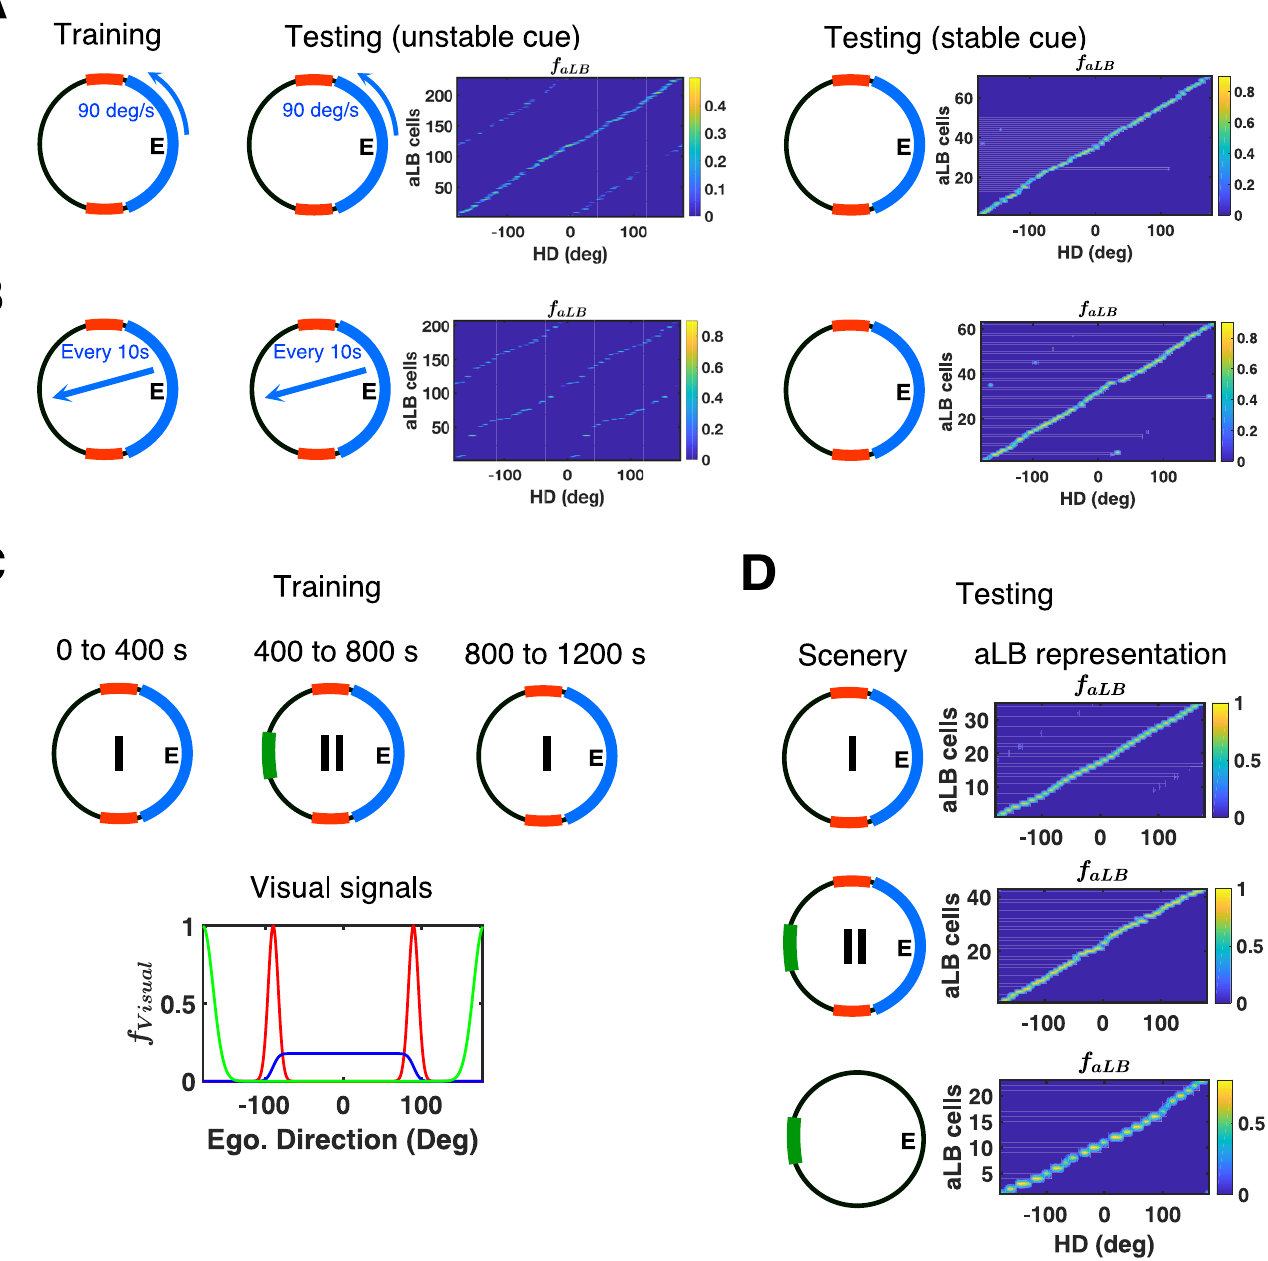
Fig 3. aLB cells exhibit robustness against unstable or ephemeral cues, and can incorporate novel cues. (A) Single environment (same as Fig 1B) with the ‘blue’ cue moving along the cylinder with 90 deg/s anticlockwise during training (left). Global representation of aLB cells tested on the unstable scenery with ‘blue’ cue moving by 90 deg/s anticlockwise (middle, ε = 0) and the stabilised scenery with ‘blue’ cue fixed after learning has stopped (right, ε = 0.5). (B) Single environment (same as Fig 1B) with the ‘blue’ cue teleporting to a random position on the cylinder every 10 seconds (left). Global representation of aLB cells tested on the unstable scenery with ‘blue’ cue teleporting every 10 seconds (middle, ε = 0) and the stabilised scenery with ‘blue’ cue fixed after learning has stopped (right, ε = 0.5). (C) Two sceneries (within the same environment) with the ‘red-blue’ scenery (Sc. I) and a ‘red-blue-green’ scenery (Sc. II). The agent stays in each scenery for 400 seconds (once from Sc. I to Sc. II and back to Sc. I), with feature-specific visual input signals in Sc. II (bottom). (D) Following the learning phase, the model is tested on the ‘red-blue’ scenery (i.e. Sc. I, top), the ‘red-blue-green’ scenery (i.e. Sc. II, middle), and the ‘green’ scenery (i.e. Sc. II with ‘red-blue’ scenery excluded, bottom). Stable unimodal aLB representations emerge in all cases (also see S3 Fig), with different sets of active cells in Sc. I vs. Sc. II (S4 Fig). Warmer colors represent higher firing rates of aLB cells. Abbreviations: HD: head direction; aLB: abstract landmark bearing; ego.: egocentric.